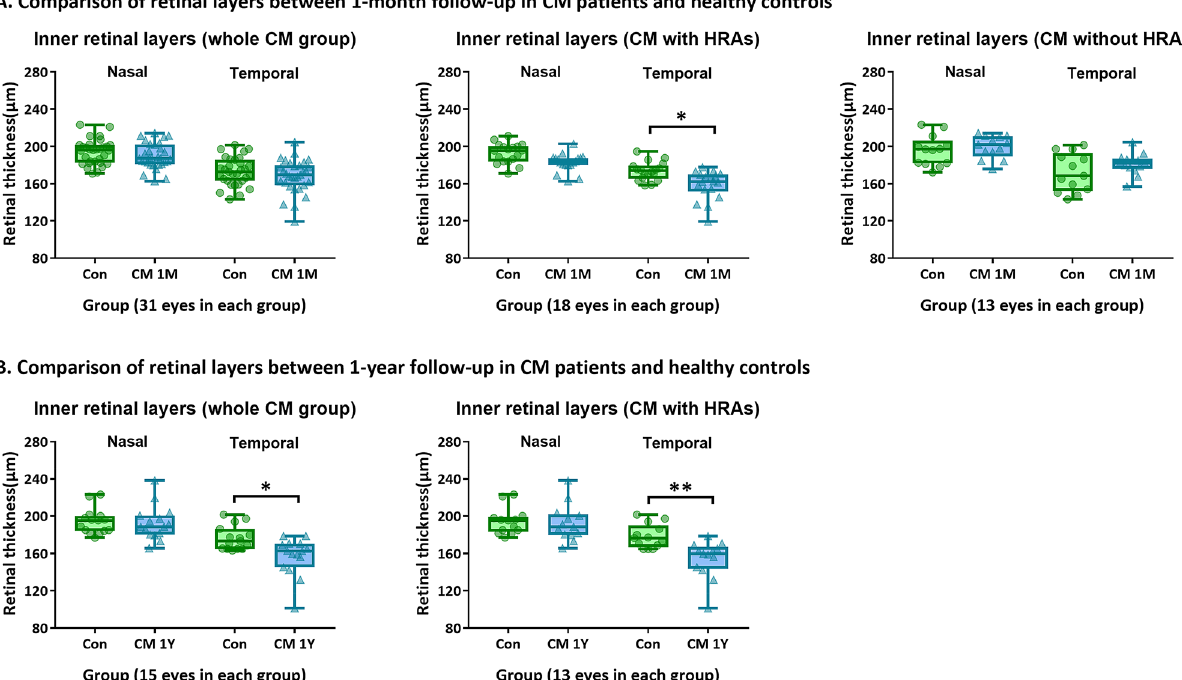
Figure 4. Comparisons of thicknesses of retinal layers between follow-up of CM patients with HRAs and healthy controls. ( A ) Comparison of thicknesses of inner retinal layers between controls and CM patients at 1-month follow-up. ( B ) Comparisons of thicknesses of inner retinal layers between controls and CM patients at 1-year follow-up. Error bars in the boxplot are the ranges of data. *p < 0.05 and **p < 0.01 show significant differences between the two groups. Control groups are in green and patient groups in blue ( Con controls, CM cerebral malaria, 1 M 1-month follow-up, 1Y 1-year